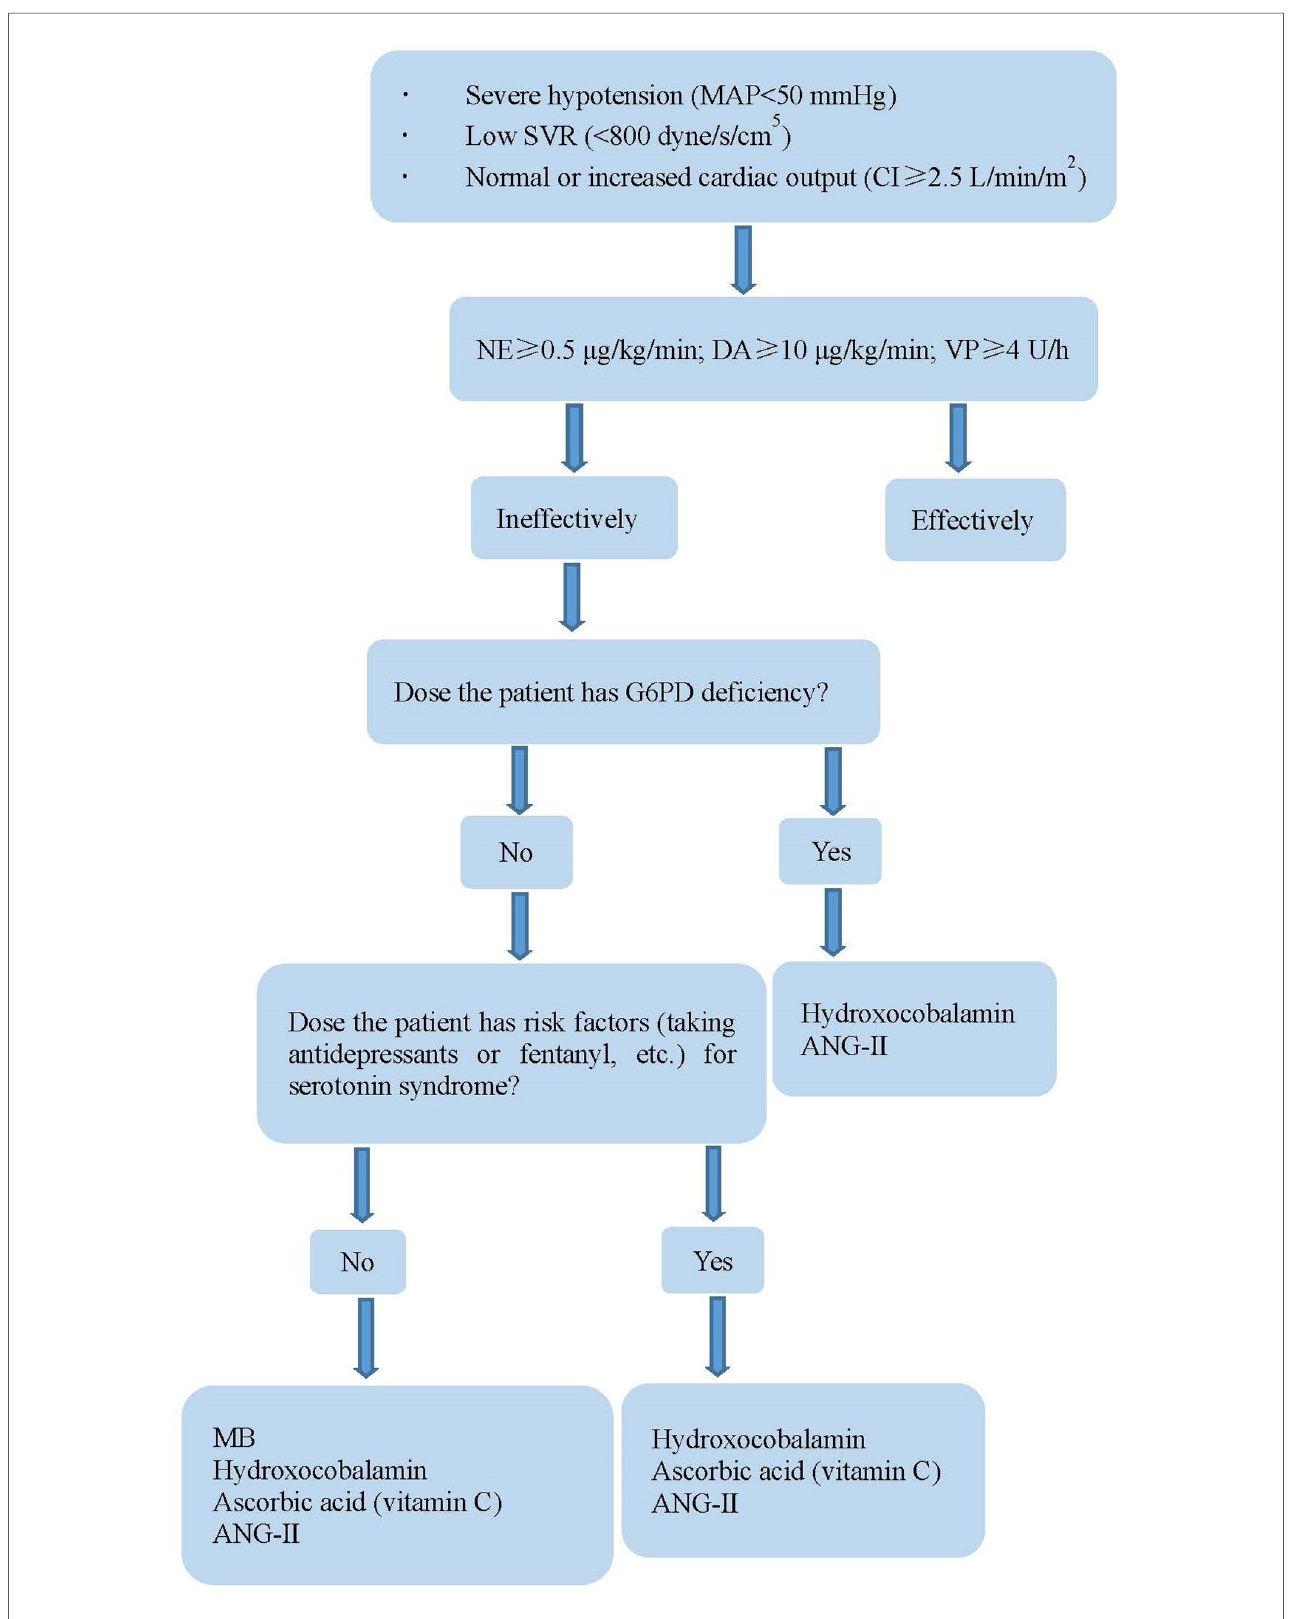
FIGURE 3 Treatment of vasoplegia during perioperative period of HTX. MAP, mean arterial pressure; NE, norepinephrine; DA, dopamine; VP, vasopressin; SVR, systemic vascular resistance; CI, cardiac index; G6PD, glucose-6-phosphate dehydrogenase; MB, methylene blue; AA, ascorbic acid; ANG-II, angiotensin